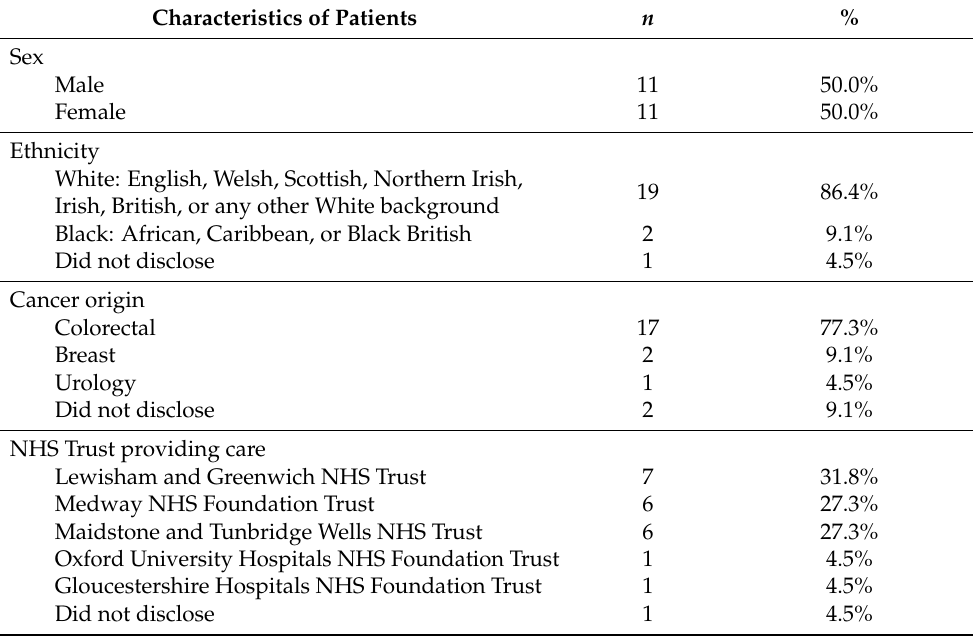
Table 2. Summary of patients’ characteristics (n = 22).